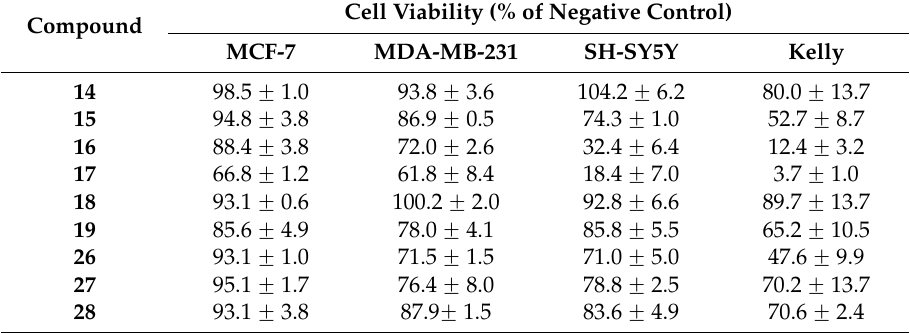
Table 1. Cell viability of cancer cell lines after treatment at 10 µ M for 72 h, given as a percentage of the negative control (DMSO). Data represents the mean values ( ˘ S.D.) for three independent